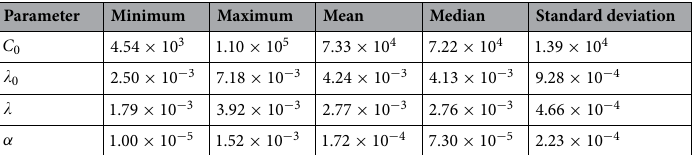
N 1 in the exponential model. = =